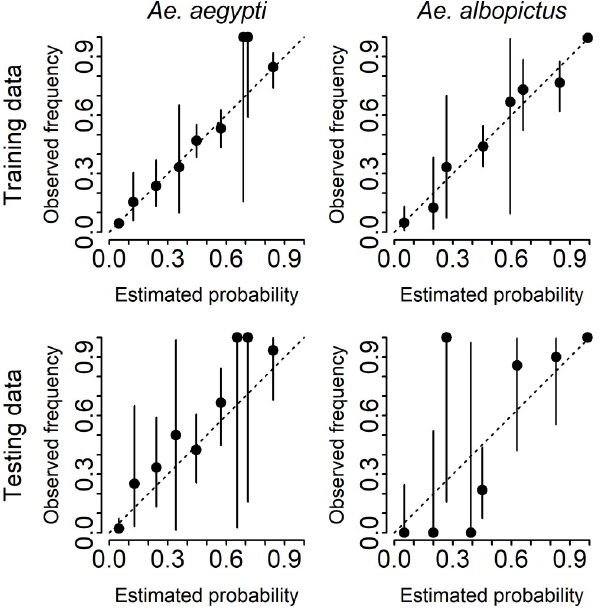
Fig 4. Model calibration. Estimated probability of presence versus the frequency of counties reporting the species as present, by decile, for Ae . aegypti (left panels) and Ae . albopictus (right panels). The predictions are compared to both the training data (top panels) and testing data (bottom panels).